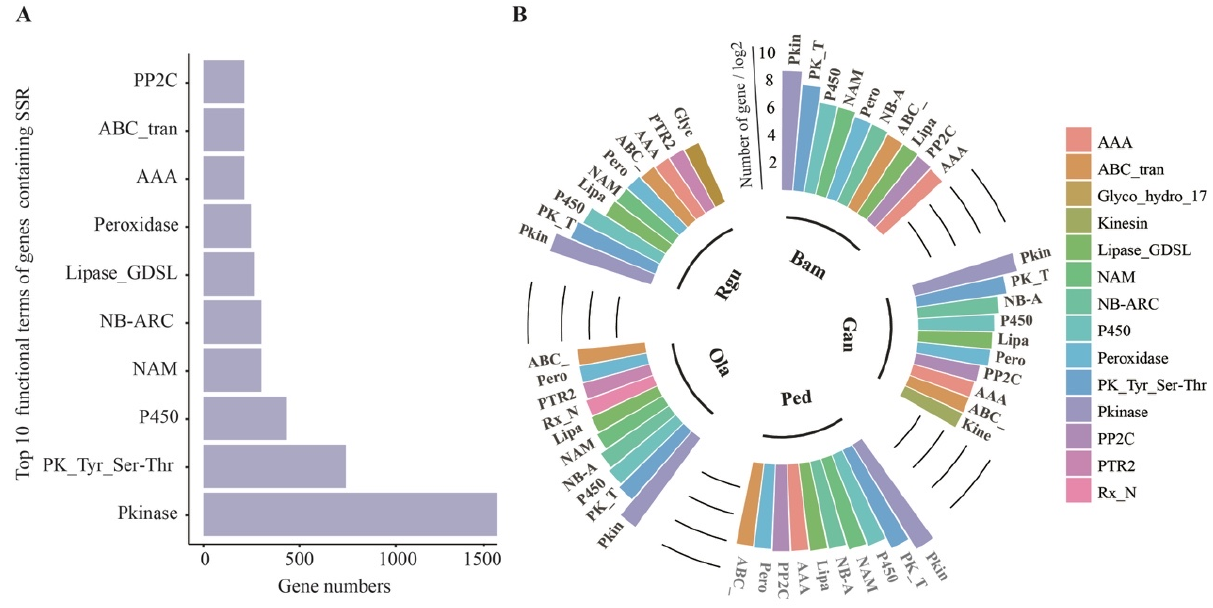
Figure 3. Statistics analysis of functional Pfam terms of SSR-containing genes in five bamboo species of B. amplexicaulis (Bam), G. angustifolia (Gan), P. edulis (Ped), O. latofolia (Ola), and R. guianensis (Rgu). ( A ) The top 10 terms of total SSR-containing genes in five bamboo species. ( B ) The top 10 terms of SSR-containing genes in each bamboo species.